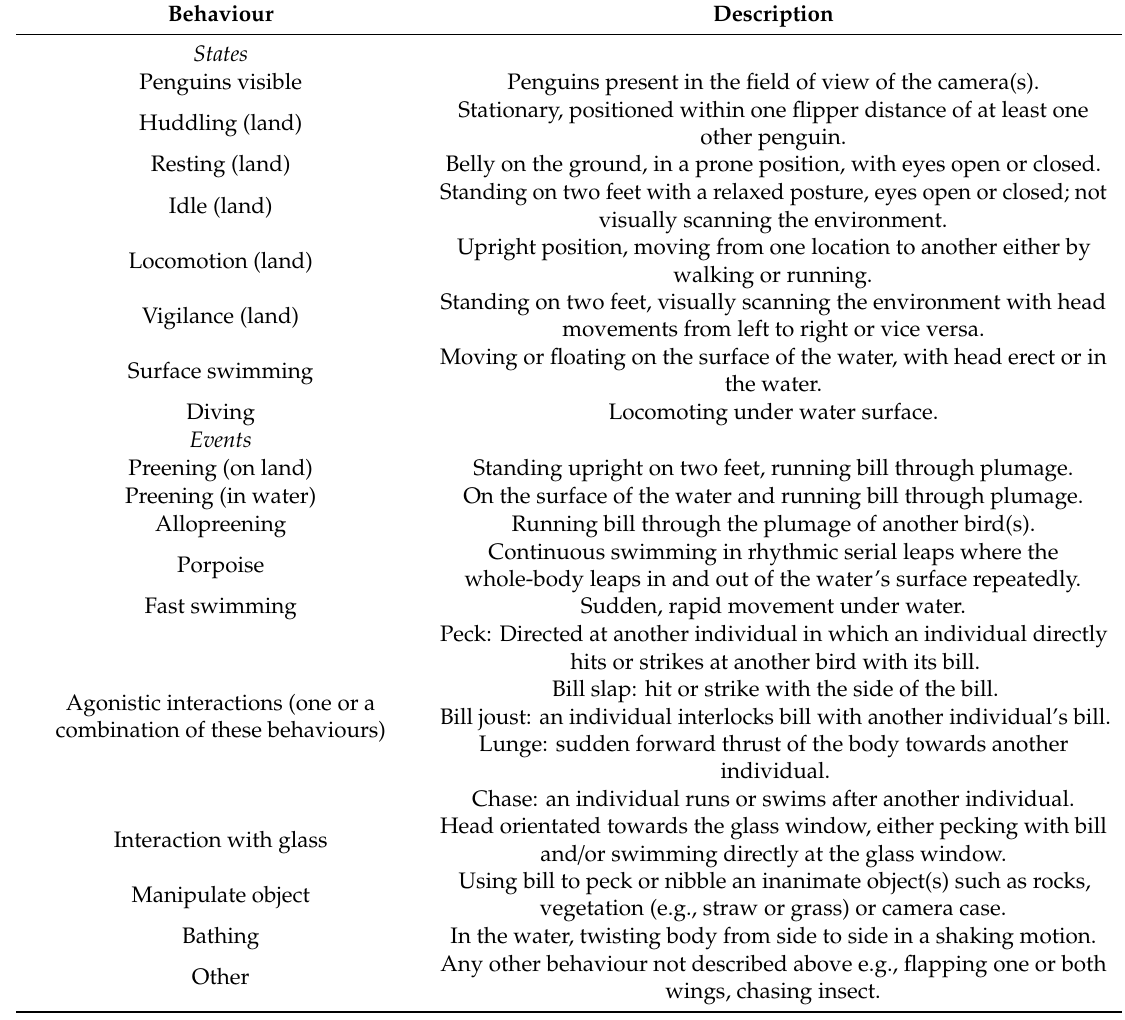
Table 1. Ethogram of penguin behaviour. Adapted from Chiew et al.